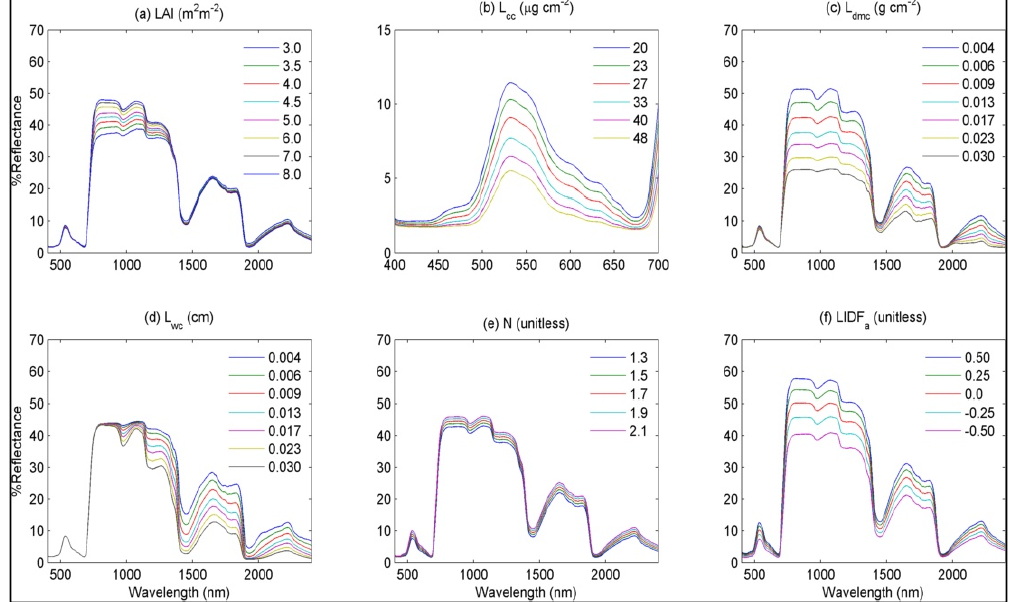
Figure 8. Variations in the spectral reflectance in nadir direction simulated by PROSAIL with respect to changing ( a ) LAI ; ( b ) leaf chlorophyll content; ( c ) leaf dry matter content; ( d ) leaf water content; ( e ) Leaf thickness parameter; and ( f ) LIDF a .